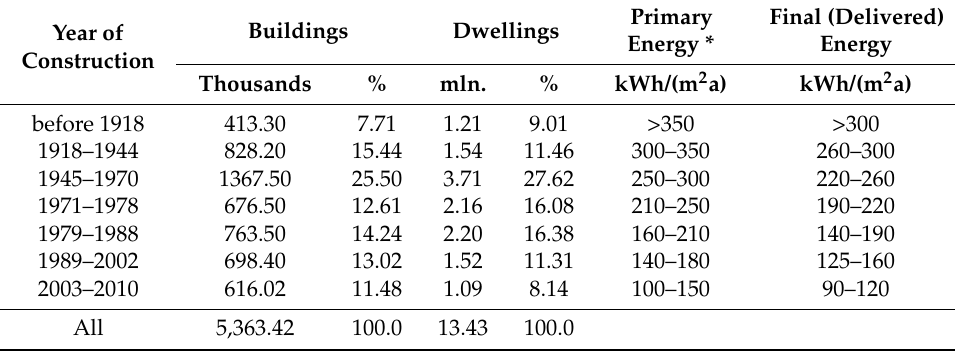
Table 6. Age structure and energy demand of Polish building stock in 2010 [7,58].